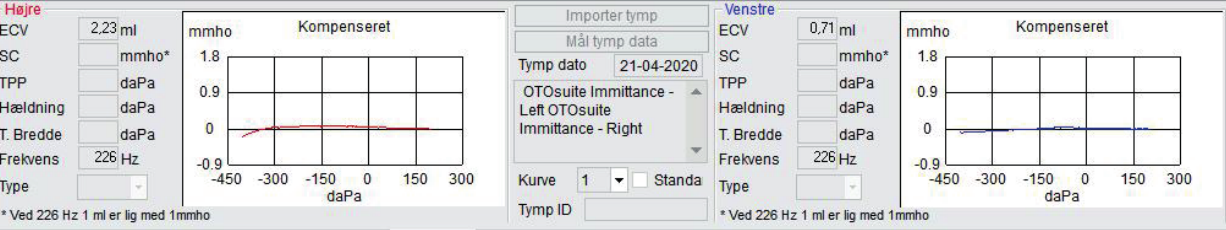
Figure 1. Hearing test two weeks prior to initiation of Dupilumab. X-axis: sound level in decibel, Y-axis: Frequency in Hertz. SRT: Speech Recognition Threshold, DS: Discrimination Score o-o: air conduction right ear, x-x: air conduction left ear.